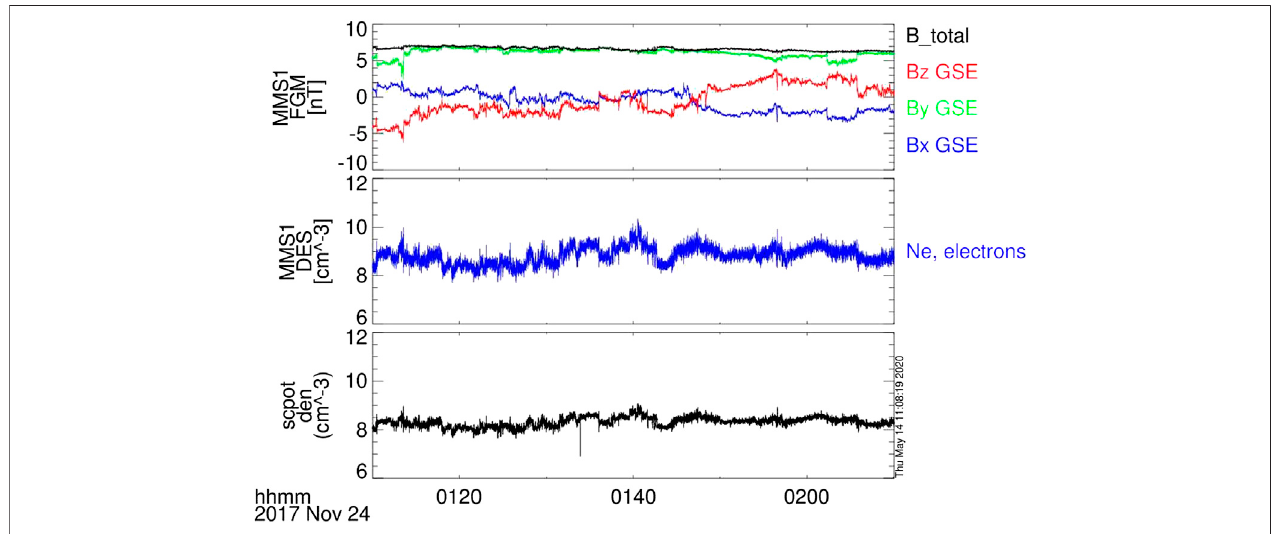
FIGURE1| MeasureddatafromMMS1duringtheintervalstudied.Toppanelshowsthethreemagnetic fi eldcomponentsandthemagnitude.Middlepanelshows the electron density measured from the FPI-DES instrument. Bottom panel shows the electron density measured from the spacecraft potential calibration method.